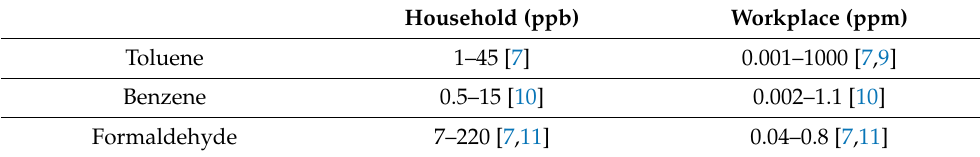
Table 1. Typical concentrations of toluene, benzene, and formaldehyde observed in indoor